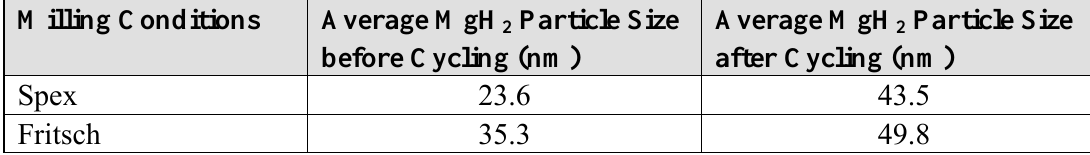
before and after 2